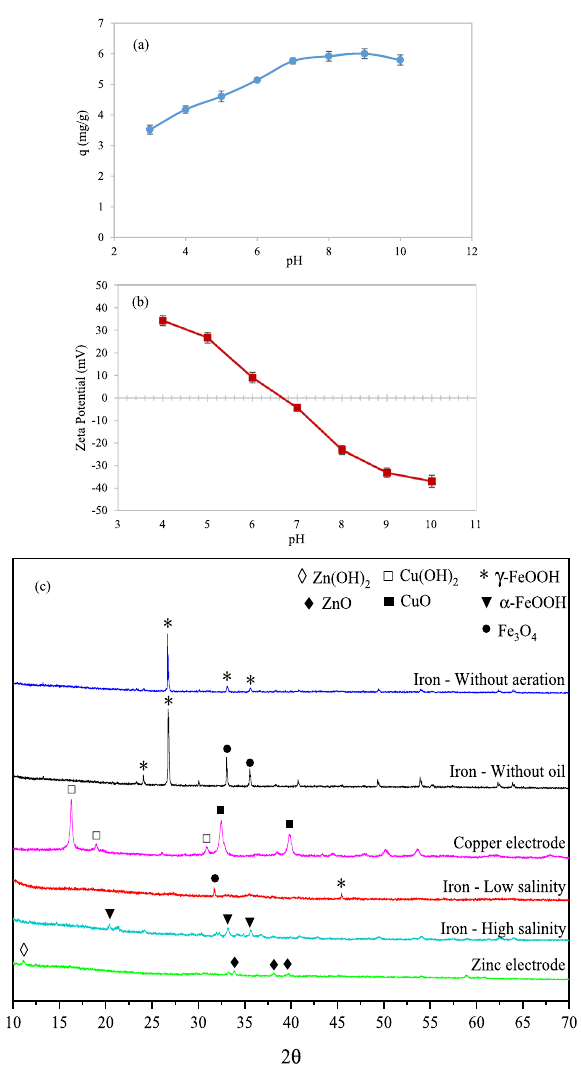
Fig. 1 Cadmium adsorption in the EC process. a Effect of pH on the cadmium adsorption capacity of the electro-generated iron oxy- hydroxide particles; b zeta potential of the iron particles as a function of pH; c XRD pattern of the produced fl ocs at various conditions. (Experimental conditions: pH 7, current density 25 mA cm − 2 , salinity 43.5 g L − 1 ). Error bars represent standard deviations.